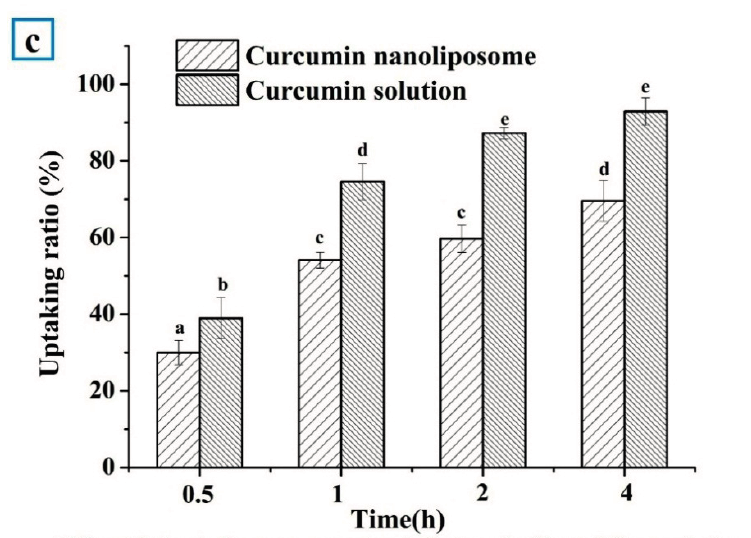
Figure 9. Fluorescence microscope analysis of Caco-2 cells treated with 20 μ g/mL free curcumin and curcumin nanoliposome after a defined period of time ( a ); Flow-cytometric analysis of Caco-2 cells treated with 20 μ g/mL free curcumin and curcumin nanoliposome after a defined period of time ( b ); Uptaking ratio analysis of Caco-2 cells treated